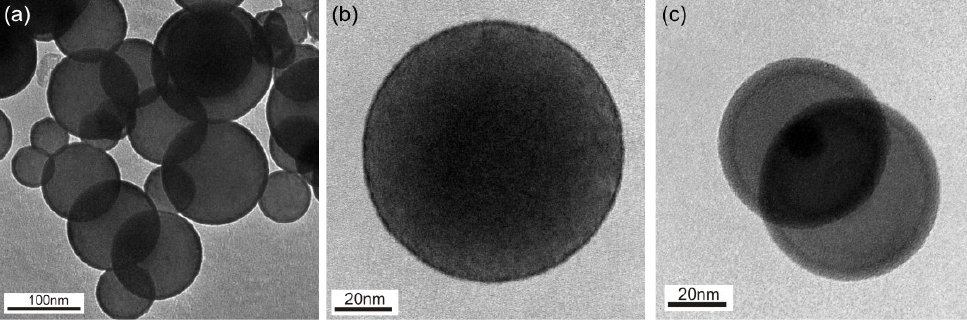
Figure 1. TEM images of core-shell structures synthesized by a (CVS)/(CVD) at atmospheric pressure, comprising a silica core and outer layers of ( a ) bismuth oxide at 390 °C; ( b ) bismuth oxide at 370 °C and ( c ) molybdenum oxide at 130